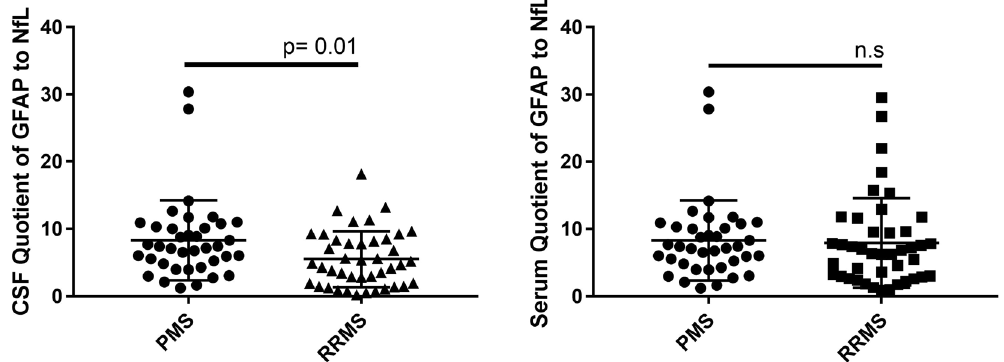
Figure 5. Quotient of glial fibrillary acidic protein (GFAP) and neurofilaments light (NfL) in cerebrospinal fluid (CSF) and serum in progressive multiple sclerosis patients (PMS) compared to relapsing-remitting multiple sclerosis (RRMS). n.s.: not